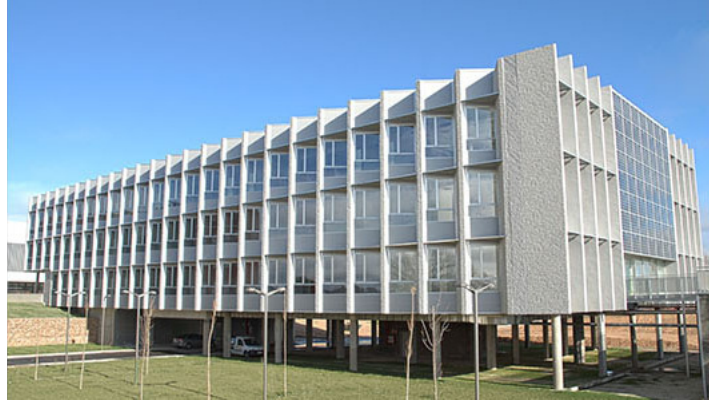
Figure 1. General view of the LUCIA building.